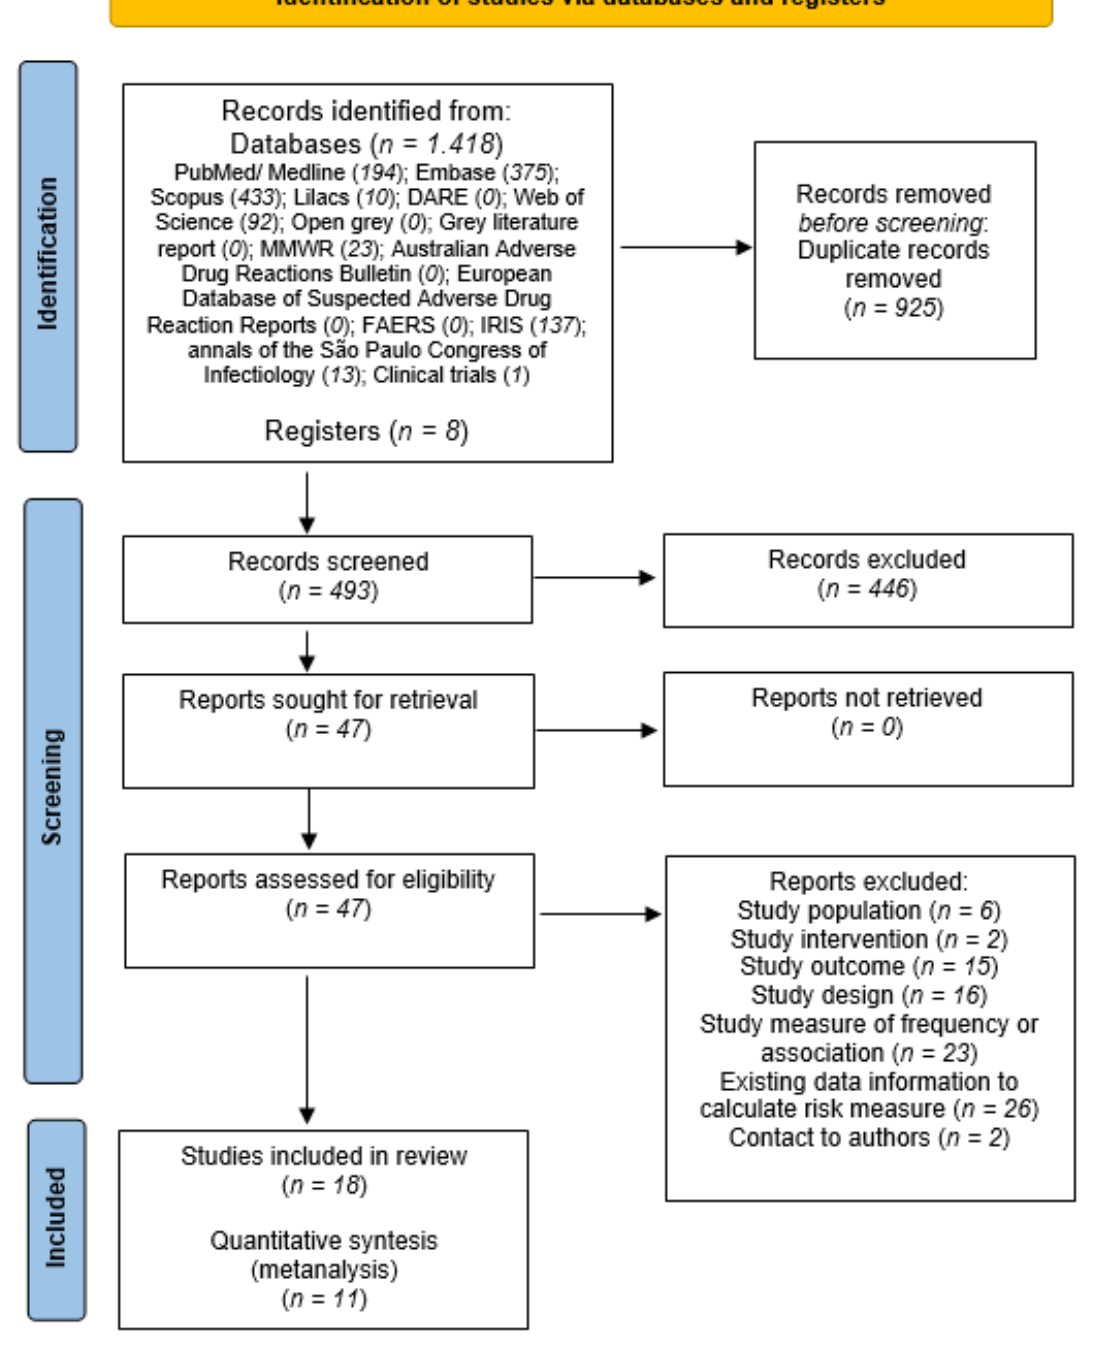
Figure 1. Process of study selection of systematic review and meta-analyses.